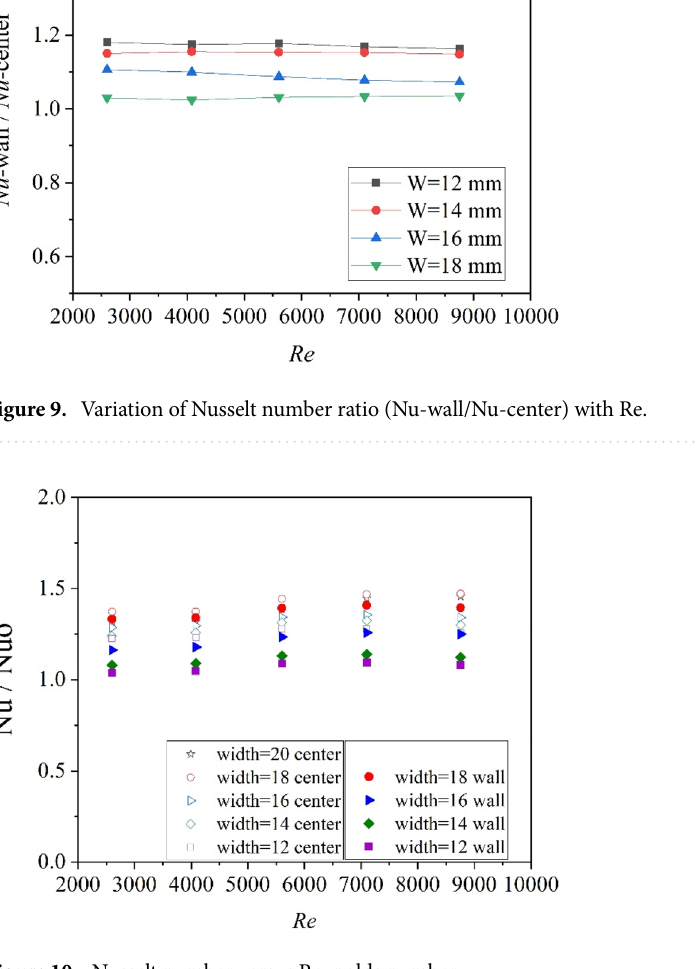
Figure 10. Nusselt number versus Reynolds